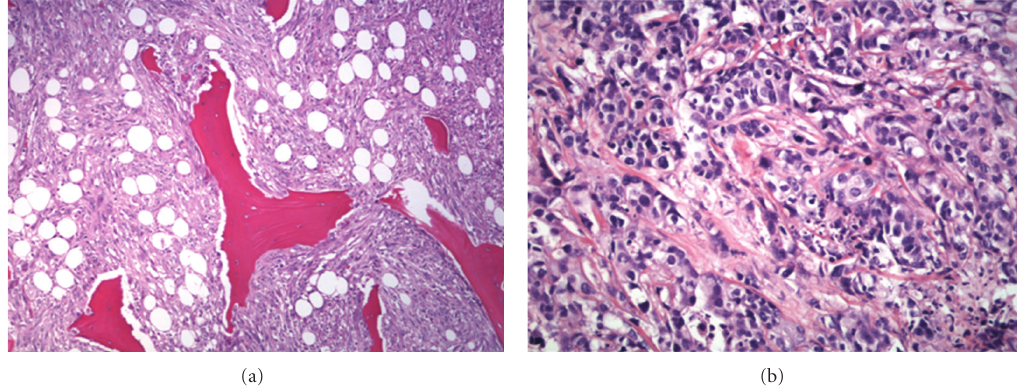
Figure 4: (a) Biopsy specimen of the proximal left femur of a 69-year-old Caucasian male with diagnosis fibroblastic osteosarcoma (200x), H.E. (b) same patient, invasive medium- to-low di ff erentiated urothelial carcinoma of the bladder (400x),